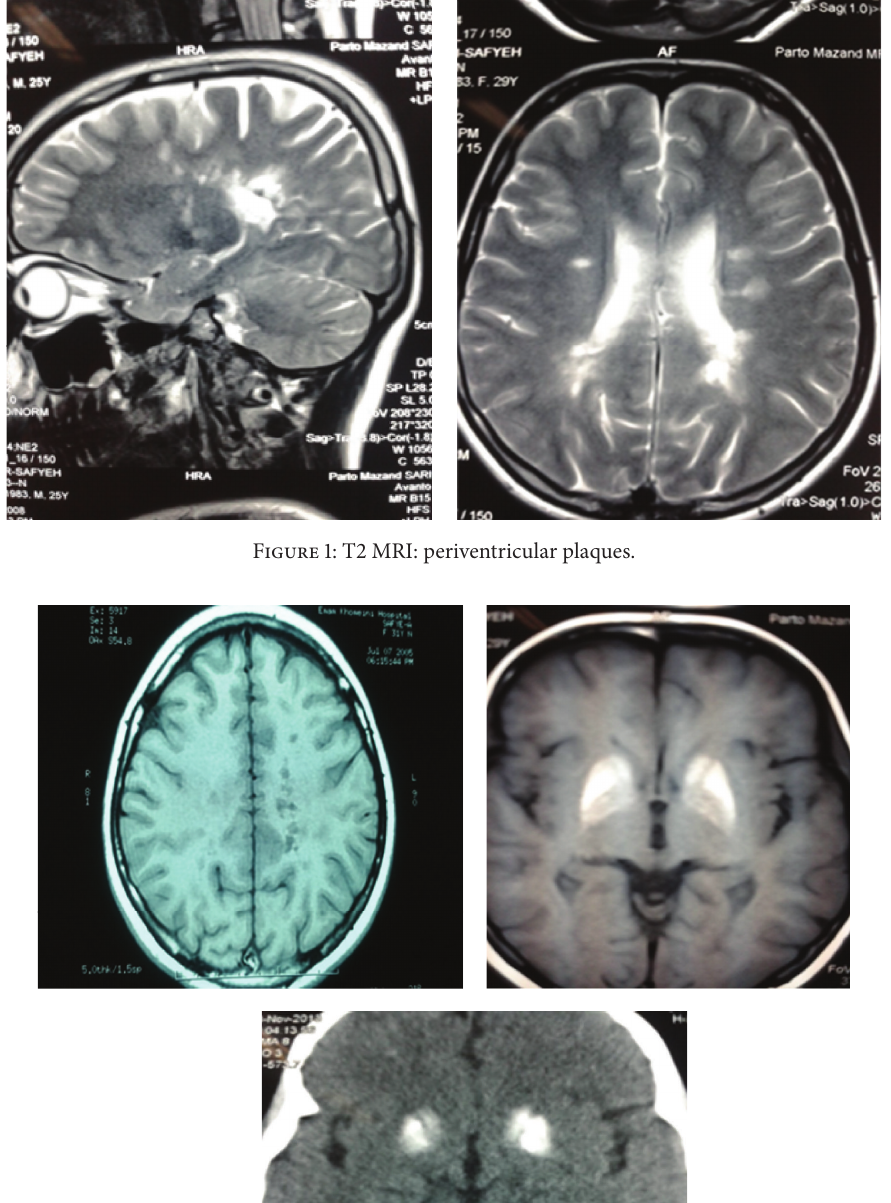
at bilateral basal ganglion and cerebellar and also black holes (Figure 2). Computerized tomography (CT) of the brain confirmed bilateral and symmetric calcifications most prominent in the cerebellar hemispheres and basal ganglia